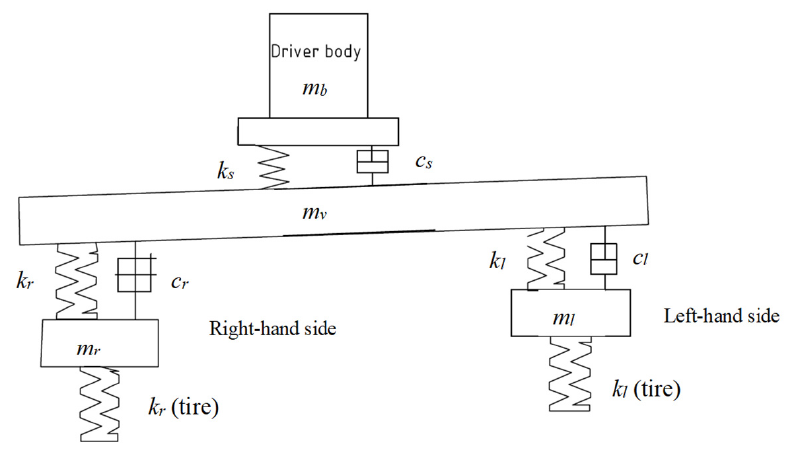
Figure 23. Simplified half-vehicle model of vehicle seat suspension.